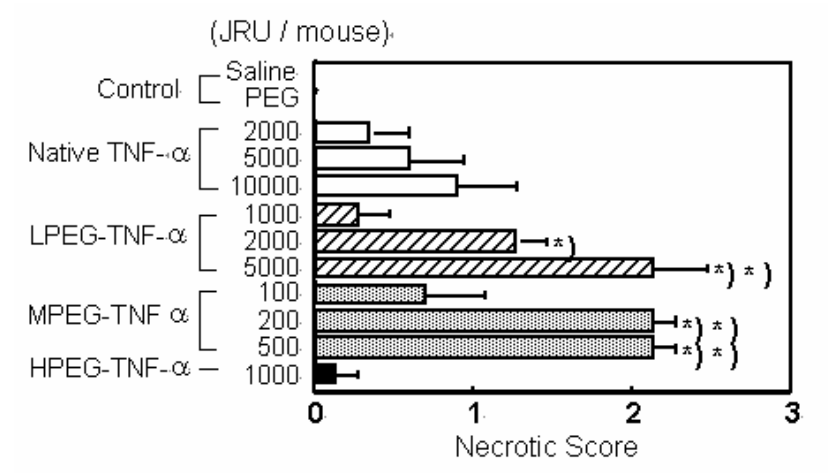
Figure 2. PEGylation of TNF- α and IL-6 selectively increase their therapeutic effects. a) Tumor necrosis effects of native TNF- α and PEG-TNF- α s on Meth-A solid tumors. Each value represents mean ± S.E. ∗ P<0.001, ∗∗ P<0.05 significantly different from the group treated with 10,000 JRU of native TNF- α